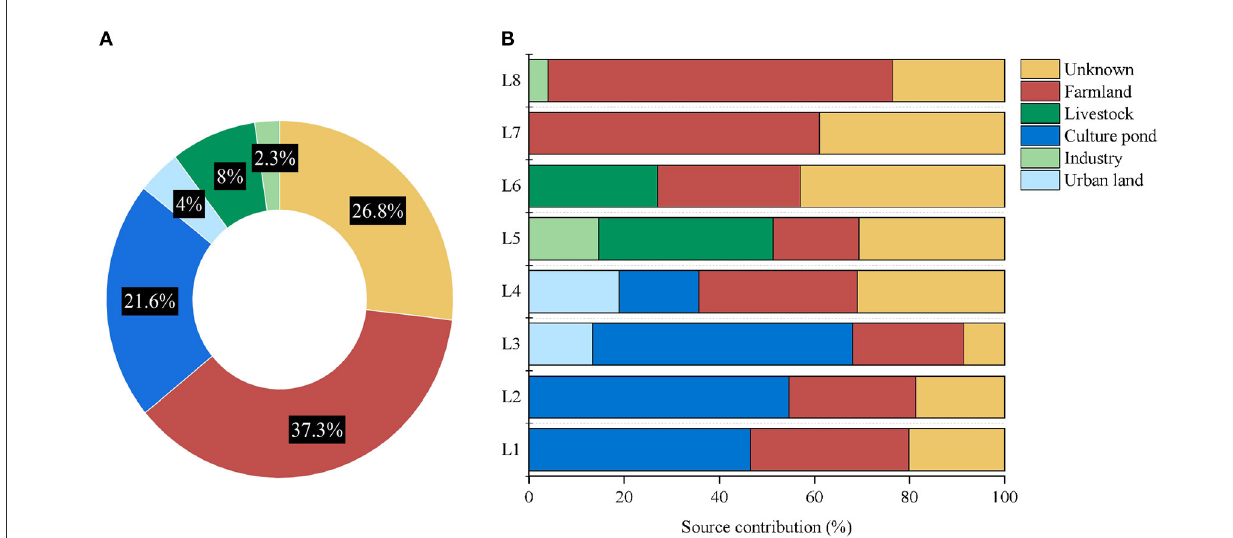
FIGURE6 Contribution of pollution sources, (A) Average contribution of different pollution sources to the Wanggang River and (B) the contribution of different pollution sources at each sampling